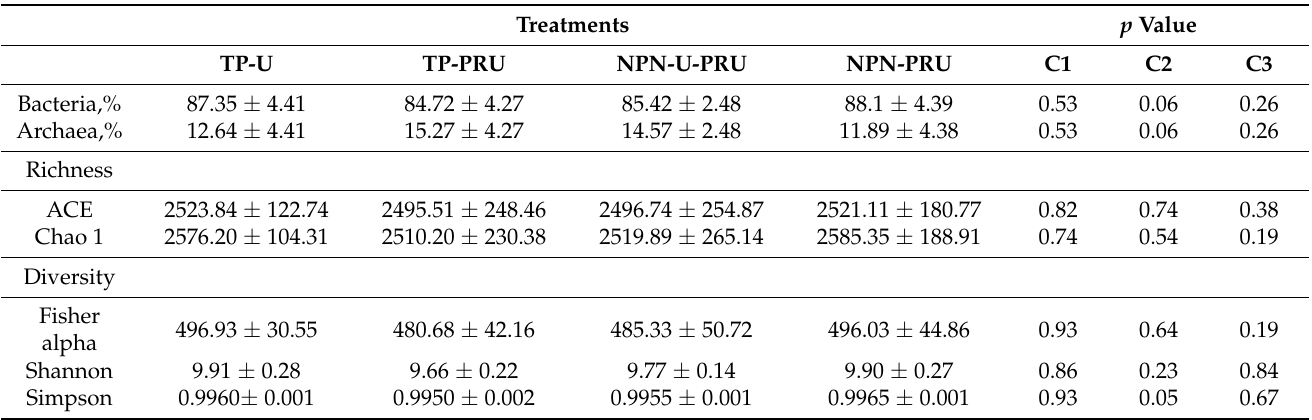
Table 5. Median and interquartile range of Bacteria, Archaea, in Nellore steers supplemented with post-ruminal urea and conventional urea during the seasonal period (exp.1).